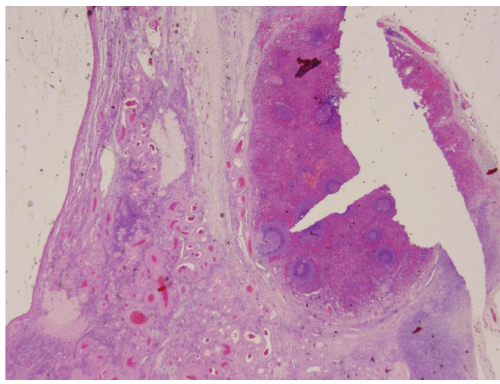
Figure 1: Left ovarian tissue with serosal splenic nodule.